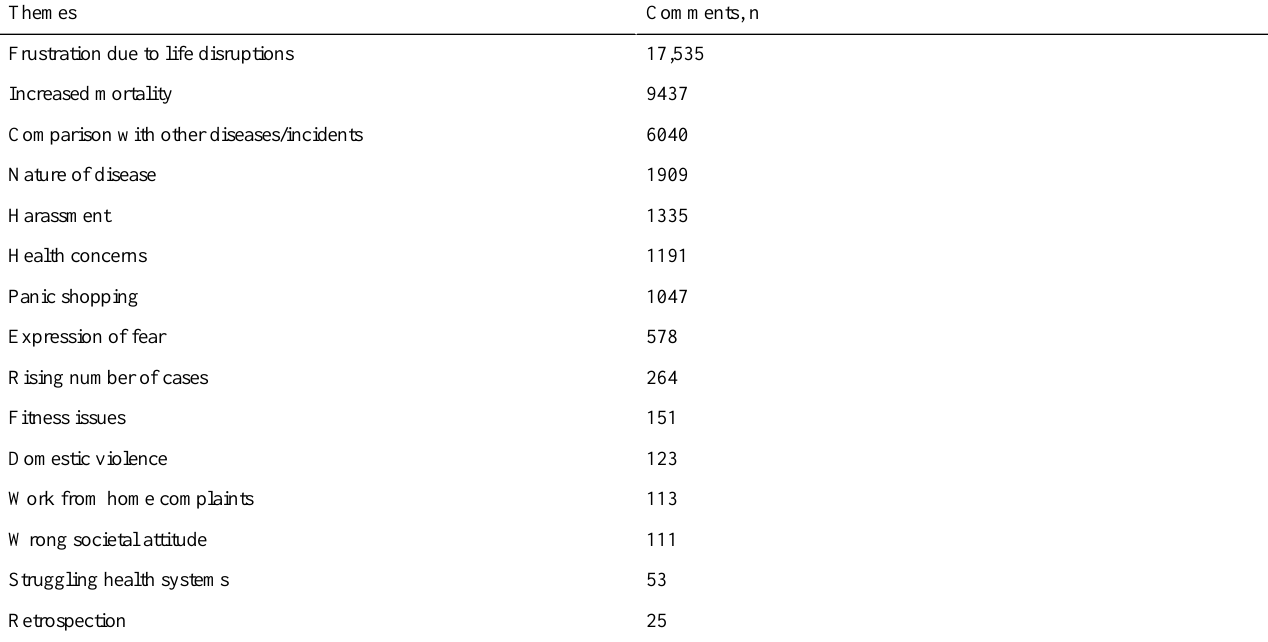
Table 6. Negative themes and the corresponding number of